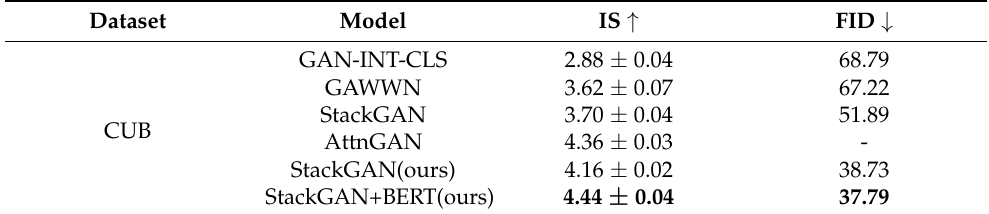
Table 2. IS and FID of GAN-INT-CLS, GAWWN, AttnGAN, StackGAN, StackGAN(ours), and our proposed model on the CUB